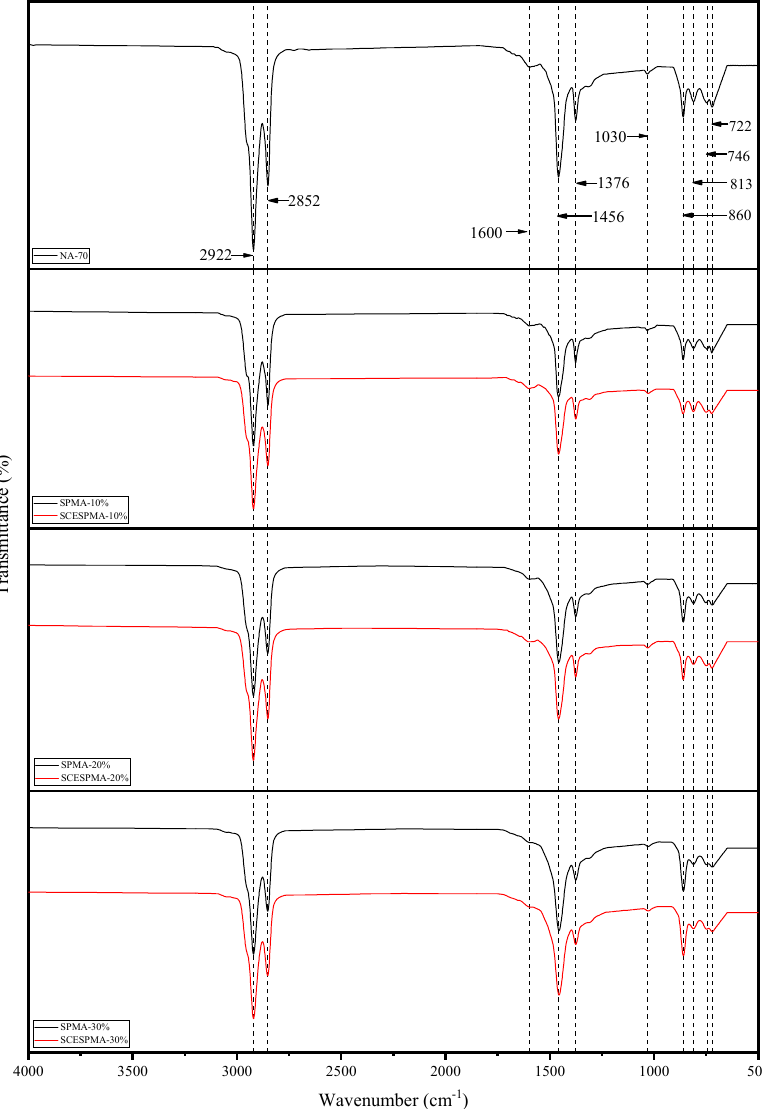
Figure 8. Functional groups of SPMA and SCESPMA.